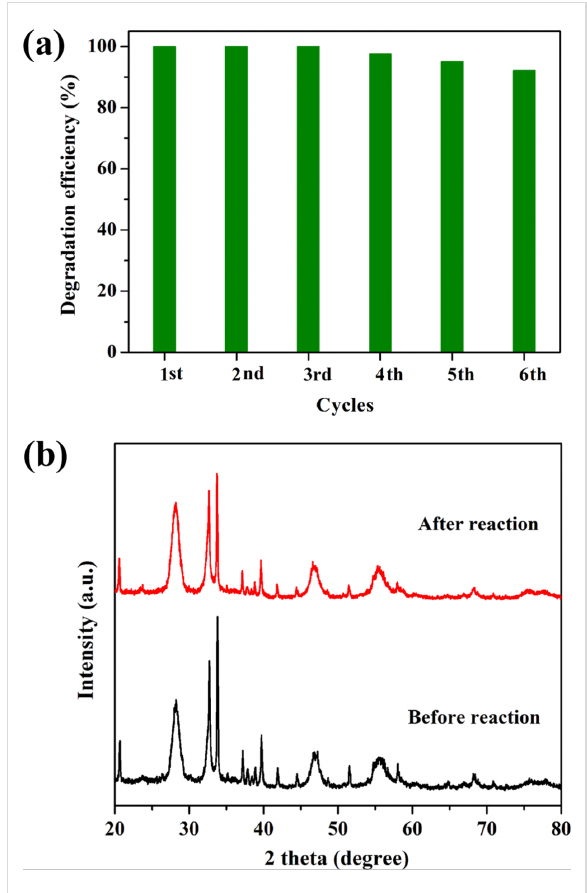
Figure 8: (a) The cycling performance of ACO/BMO-30. (b) The XRD patterns of ACO/BMO-30 before and after five reaction cycles.